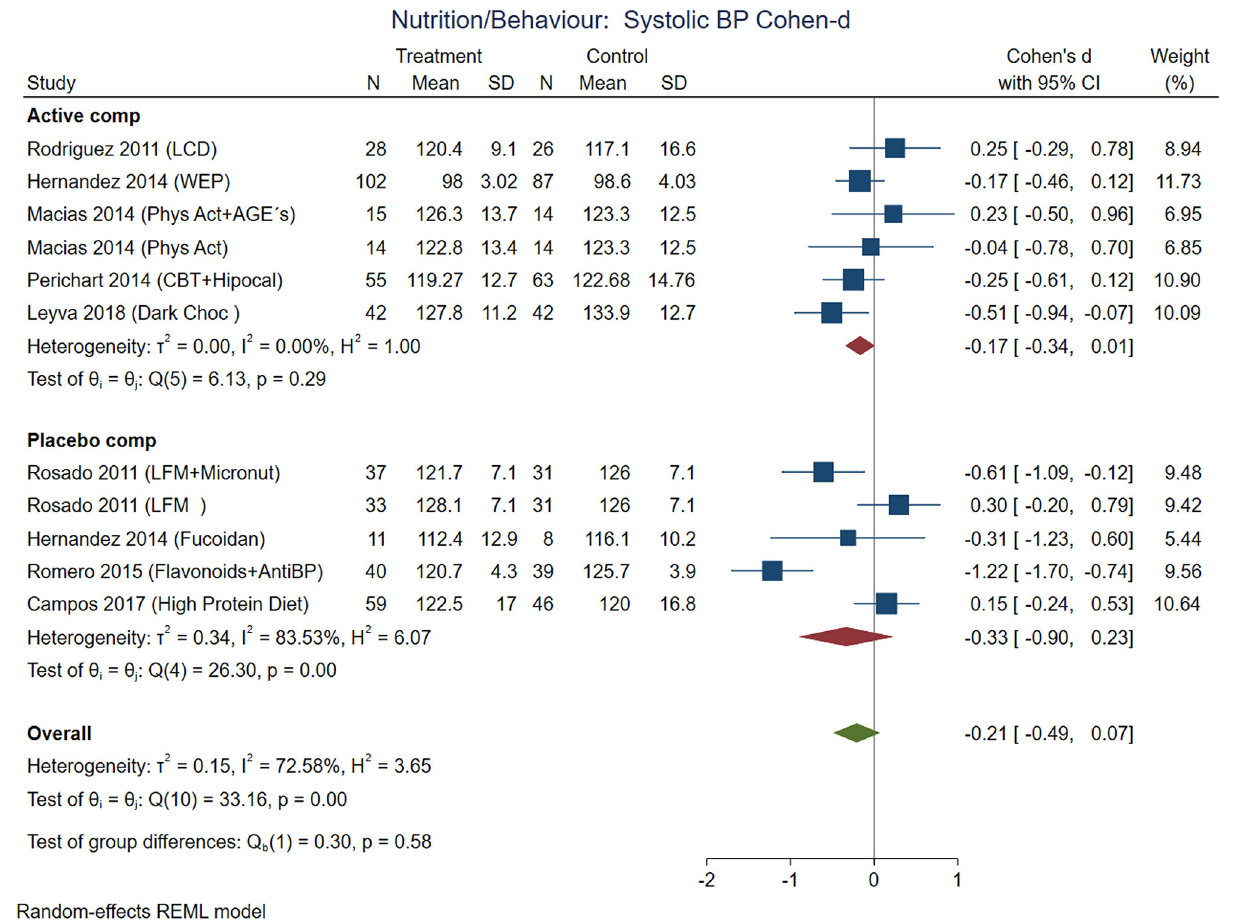
FIGURE 6 | Pooled analysis of Cohen’s d-weighted effect size on systolic blood pressure with nutritional and behavioral interventions. The analysis was stratified by placebo or active comparator. LCD, Low carbohydrate diet; CBT, Cognitive-behavioral therapy; Phys Act, Physical activity; Dark Choc, Dark chocolate;